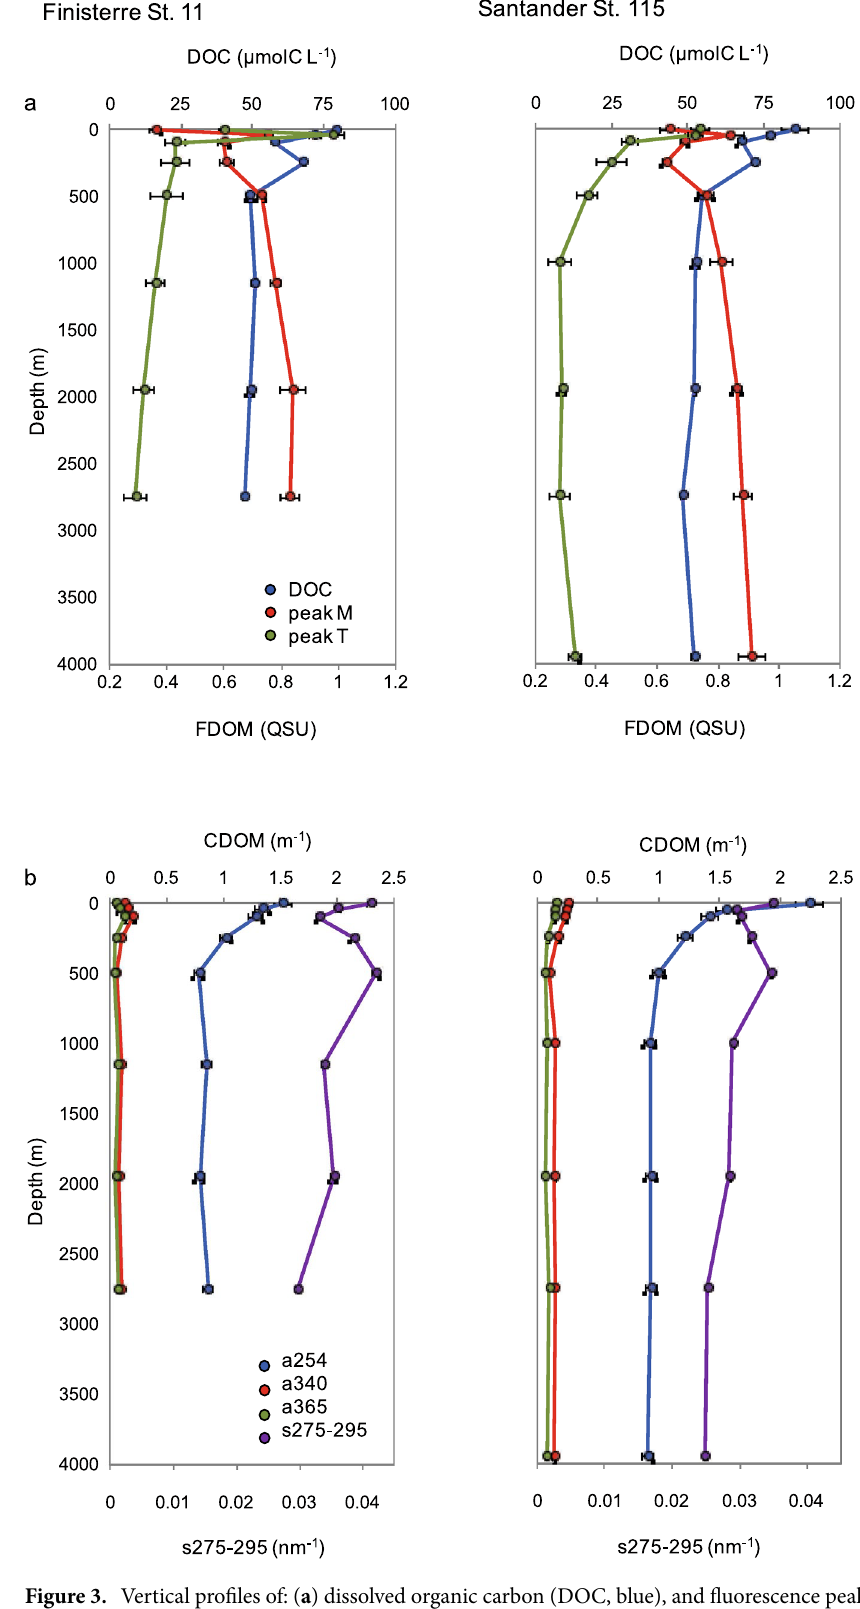
Figure 3. Vertical profiles of: ( a ) dissolved organic carbon (DOC, blue), and fluorescence peaks: peak M (red) and peak T (green); ( b ) absorption coefficients at 254 nm (a254, blue), 340 nm (a340, red) and 365 nm (a365, green), and the absorption slope s275-295 (violet), for Finisterre (left) and Santander (right)